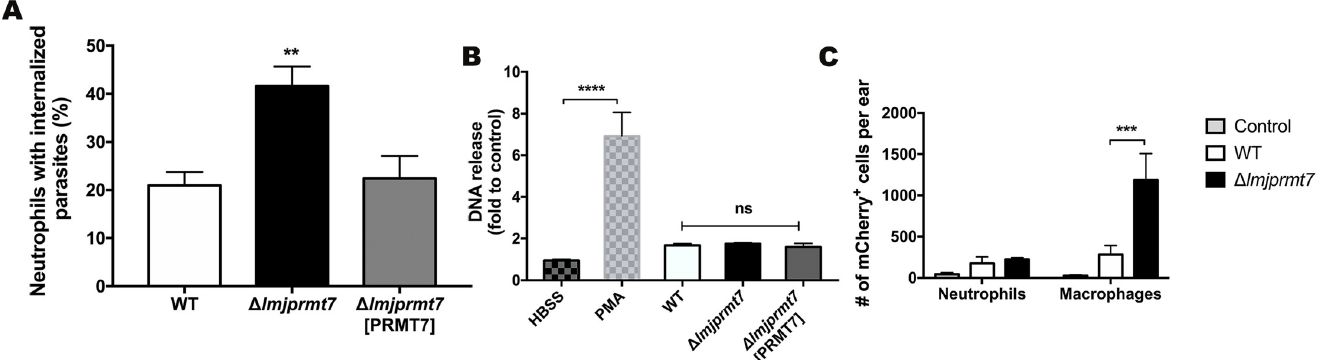
Fig 6. Neutrophils display increased uptake of parasites lacking PRMT7 in in vitro assays. (A) To evaluate the uptake of parasites by neutrophils, 10,000 BMDN were incubated for 3 hours with metacyclic promastigotes (MOI 1). The cells were centrifuged on slides and stained for evaluation by light microscopy. Data are expressed as the mean of neutrophils with intracellular parasites ± SEM. �� p < 0.01. Statistical analysis was performed by ordinary one-way ANOVA followed by Tukey’s multiple comparison test. These results are a pool of 3 independent experiments. (B) NET formation was assessed after incubating 10,000 BMDNs